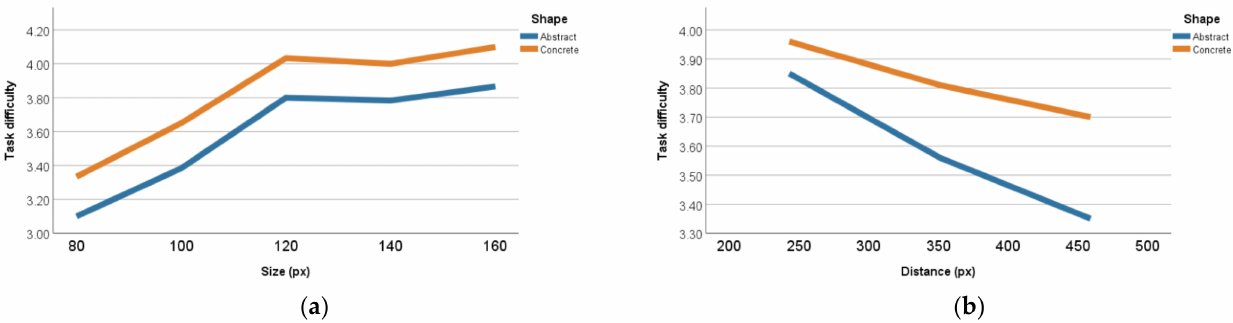
Figure 13. ( a ) The subjective evaluation analysis of size and shape; ( b ) the subjective evaluation analysis of distance and